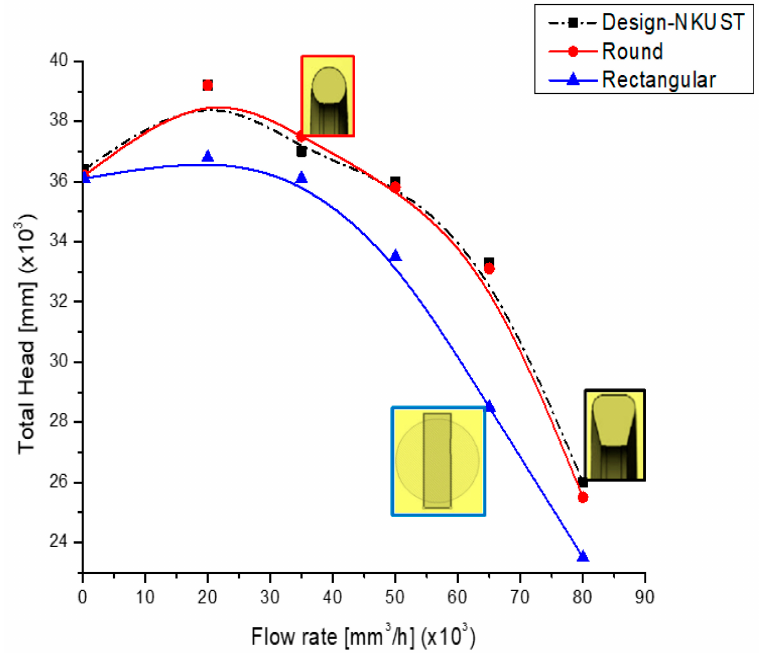
Figure 12. The comparison of three types of volute casing